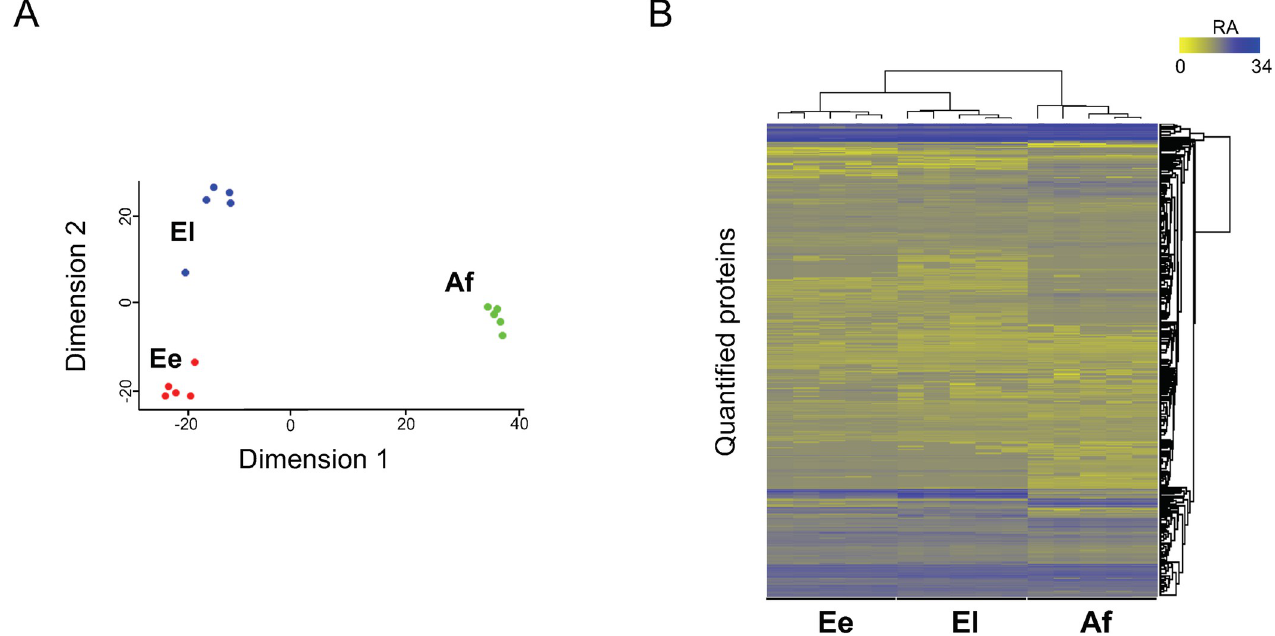
Fig 2. Analyses of the somatic proteome of Sarcoptes scabiei . ( A ) Principal component analysis (PCA) of the somatic proteomes of eggs at an early stage (Ee), eggs at a late stage (El) of embryonation/development, and adult females (Af) of Sarcoptes scabiei , respectively. ( B ) Heatmap displaying the expression profiles for these three distinct developmental stages. Normalised protein abundance is shown in a grey-to-blue scale (i.e., low to high abundance).